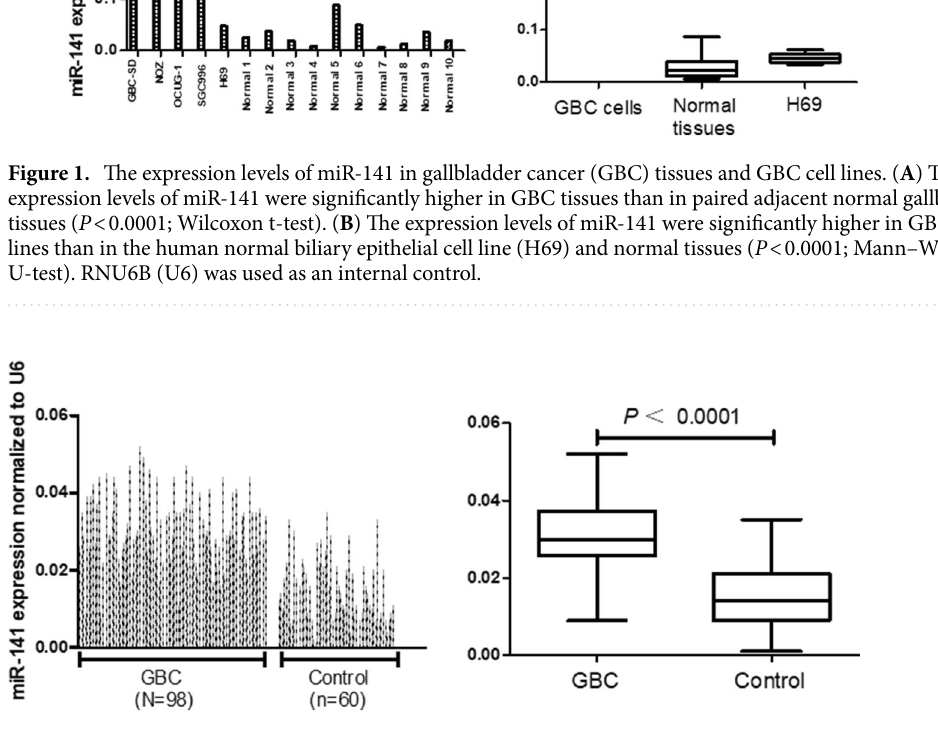
Figure 2. The expression levels of circulating miR-141 in plasma samples. The circulating miR-141 expression in plasma were significantly higher in gallbladder cancer (GBC) patients (n = 98) than in healthy controls (n = 60) ( P < 0.0001; Mann–Whitney U-test). RNU6B (U6) was used as an internal